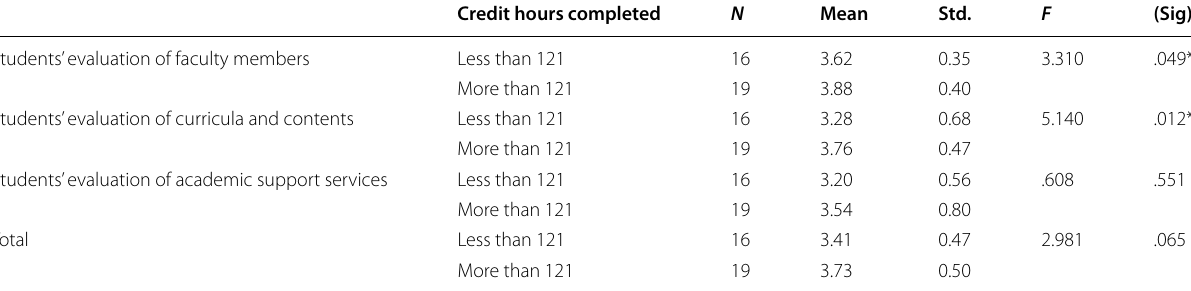
Table 5 Means, standard deviations, and one-way ANOVA analysis of students’ evaluation of the FS program at the Al-Istiqlal University according to the credit hours completed